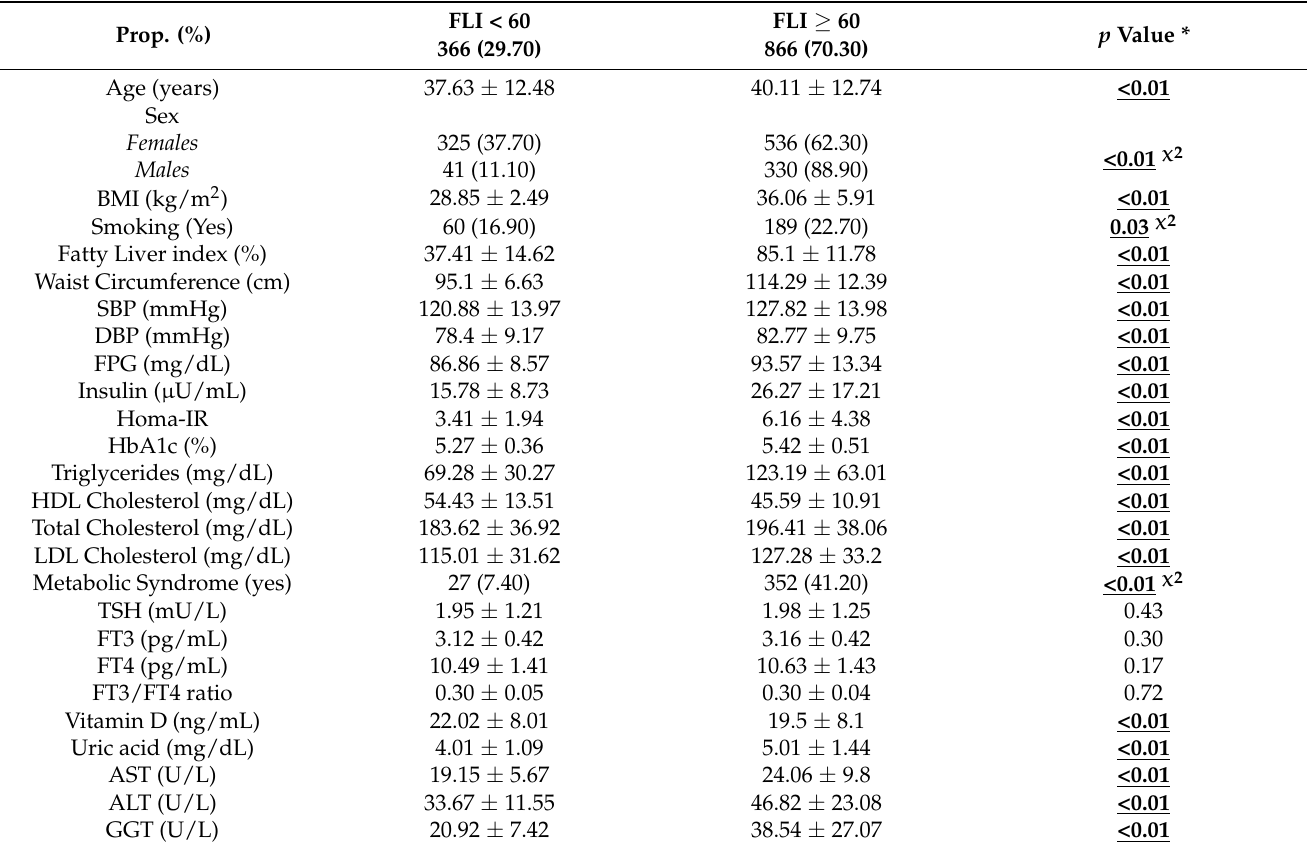
Table 1. Description of the whole sample according to Fatty Liver Index score ( N = 1232). All data are shown as mean ± SD (min to max) for continuous variables and as (%) for proportions.